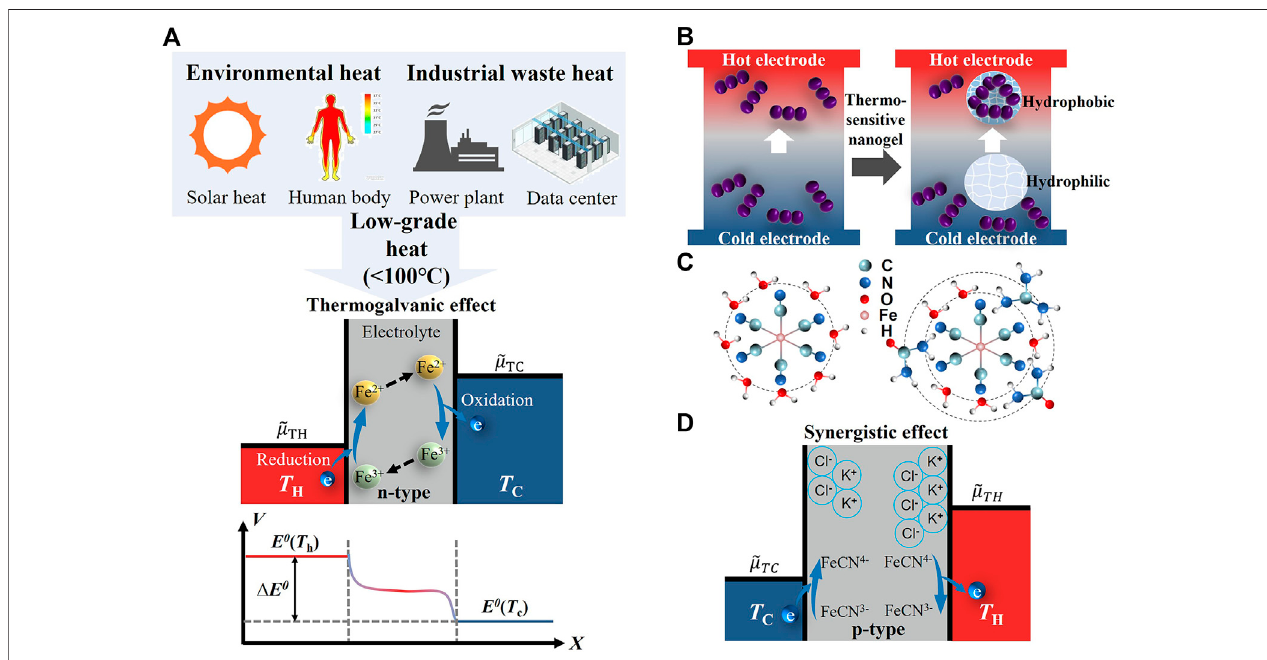
FIGURE 1 | Mechanism and strategies for performance enhancement of thermogalvanic cells. (A) Low-grade heat sources and mechanism of thermoelectric energyconversion via thermogalvaniccells(Fe 2+ /Fe 3+ ,n-type). (B) Strategyofenhancingconcentrationratiodifferences. (C) Strategyofreorganizingthesolvatedshellof the redox couple. (D) Synergistic effect of thermodiffusion and thermogalvanic effects (Fe(CN) 63 − /Fe(CN) 64 − , p-type).